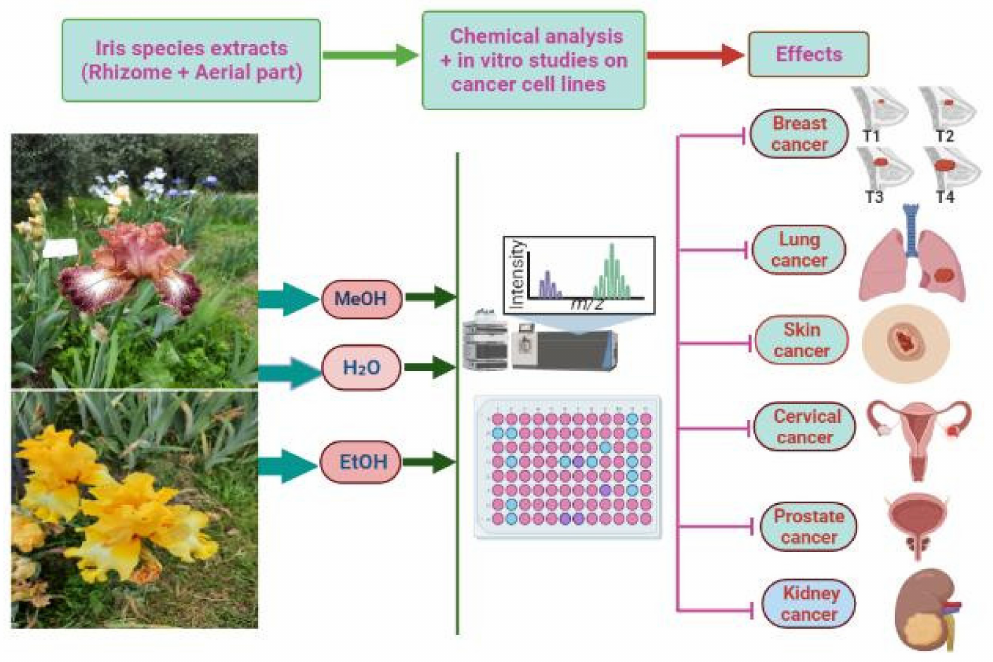
Figure 3. General approach applying to assess the anticancer effect of Iris spp. in vitro. Irilone, iriflogenin, genistein and iris kashmirianin are only a few of the flavonoids isolated from I. germanica L. that have been shown to exert chemopreventive benefits by reducing cytochrome P450 1A activity and enhancing NAD(P)H: quinone reductase (QR)activity